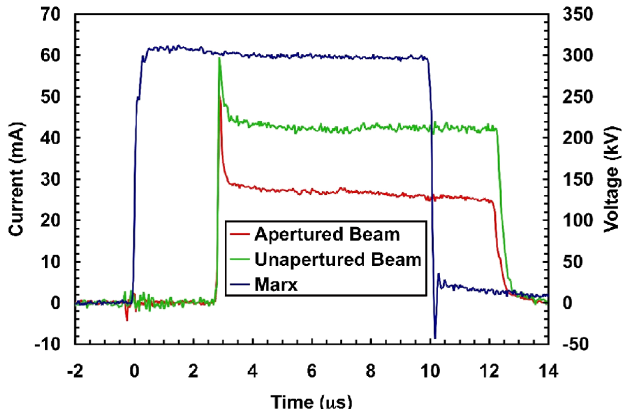
FIG. 2. (Color) Marx voltage waveform used to extract the beam through the diode (blue) and the measured beam current 54 cm downstream of the exit of four solenoids ( z (cid:5) 304 cm ) with the aperture installed (red) and without the aperture installed (green).